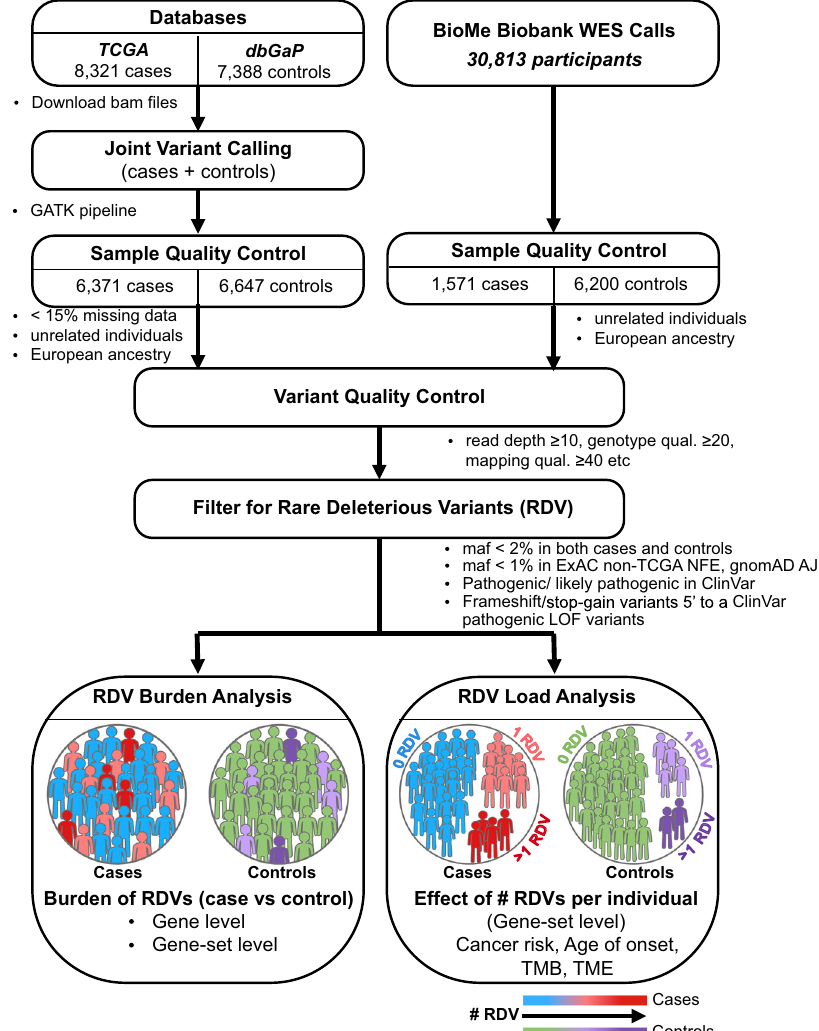
Fig. 1 Study design. Flowchart of the study pipeline to identify rare deleterious variants (RDVs) and to perform RDV burden and RDV load